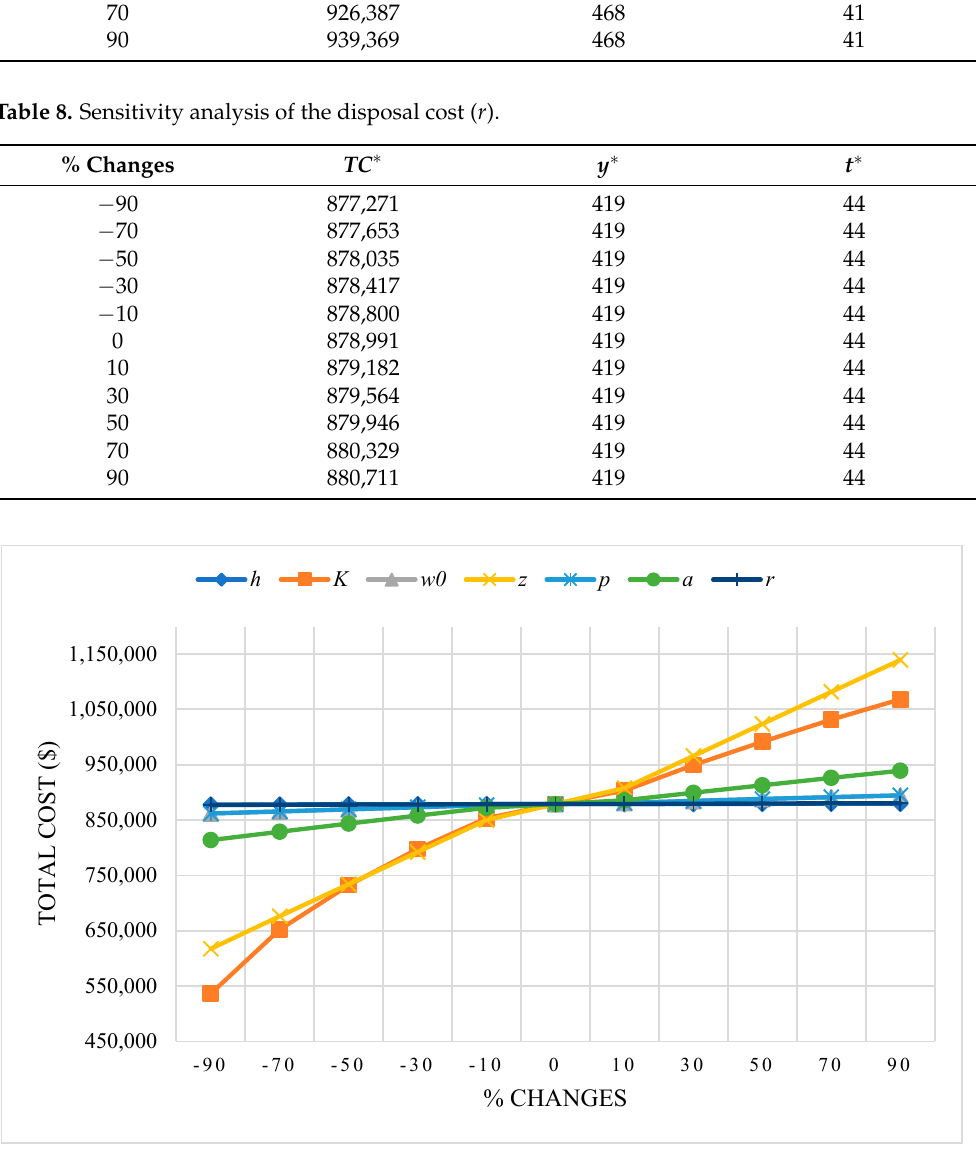
Figure 7. The effects of the parameter’s fluctuations on the optimal value of the total cost.